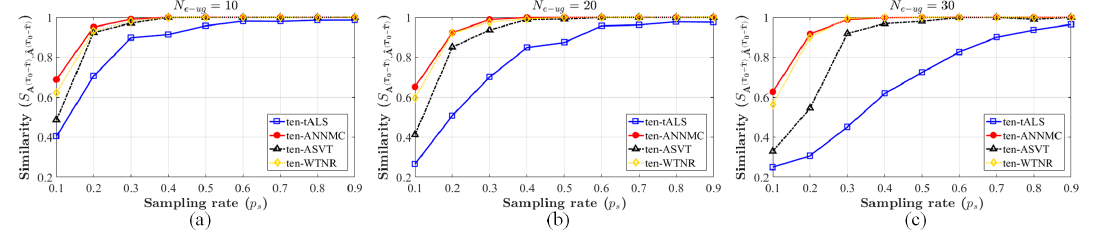
Figure 7. Comparison of similarity by different preference inferring algorithms for tensor completion (ten-tALS, ten-ASVT, ten-WTNR and ten-ANNMC) on the synthetic dataset. The number of blocks ( ˆ T ) = 10 corresponding to ( a ), 20 corresponding to ( b ) and 30 corresponding to ( c ). The range of the N e − ug non-uniform sampling-rate p s is varied from 0.1 to 0.9 and the content types I =